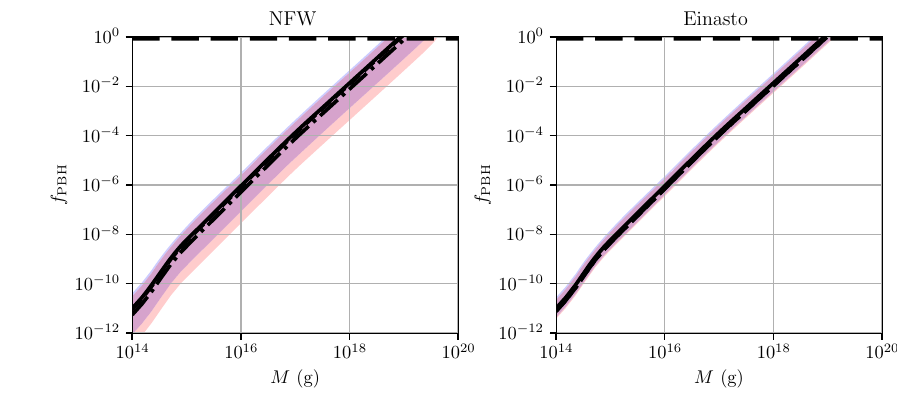
Fig. 6 Modification of the constraint f PBH for different galactic profiles, compared to the fidutial case (solid black line). Left: f PBH for a generalized NFW profile. Right: f PBH for a Einasto profile. Dashed (dot-dashed) black lines correspond to the central values of the parameters of [85] and baryonic model B1 (B2); shaded blue (red) areas correspond to a complete span of the 68% CL range for all the parameters for model B1